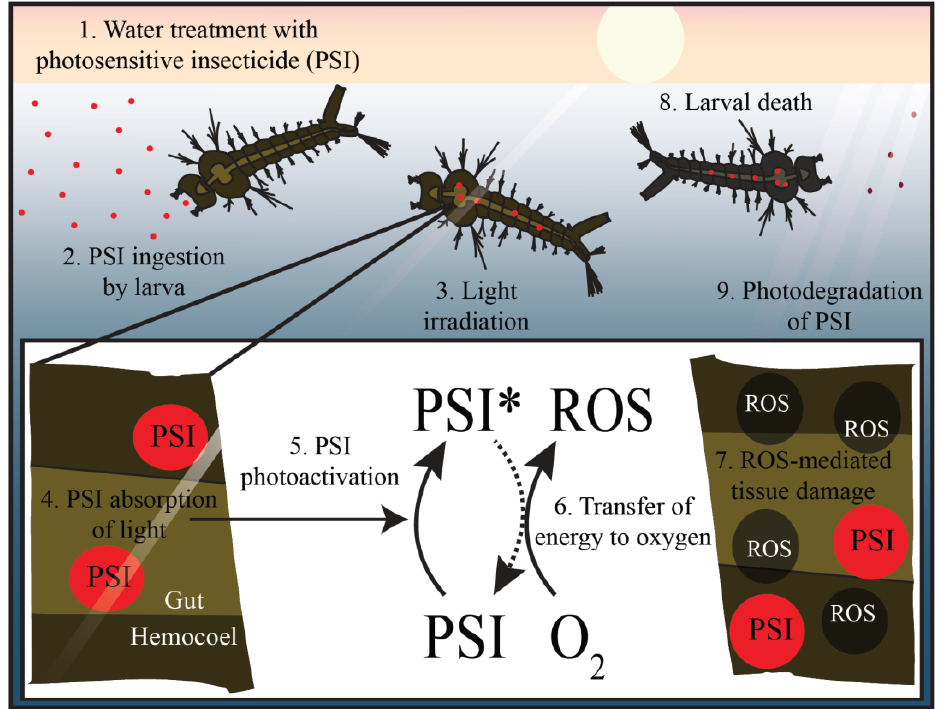
Figure 6. Photosensitive insecticides (PSIs) are ingested by larvae and kill them via oxidative damage. Photosensitive insecticides are applied to bodies of water (1), and once ingested by larvae (2), the PSIs are activated by natural light (asterisk) to produce reactive oxygen species (ROS; 3 – 6). These ROS irreversibly damage macromolecules in their vicinity, killing the larvae (7 – 8). Any PSI that is not consumed is degraded by sunlight (9).